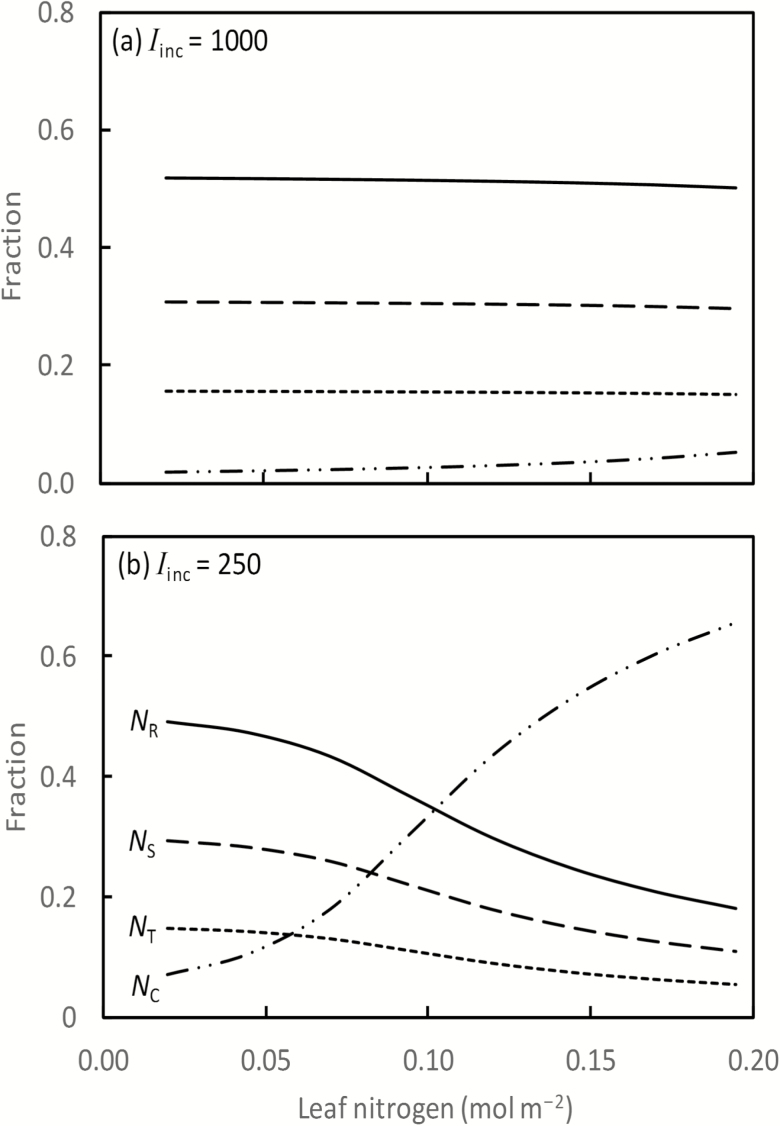
Predicted optimum partitioning of Nphoto among NC, NR, NT, and NS, as affected by Nleaf, at two levels of Iinc (µmol m–2 s–1). In this case, Cc = 250 µmol mol−1, leaf temperature=25 °C.